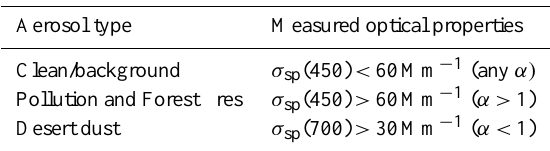
Table 2. Used criteria for different aerosol types in terms of spectral scattering coefficients and ˚Angstr¨om